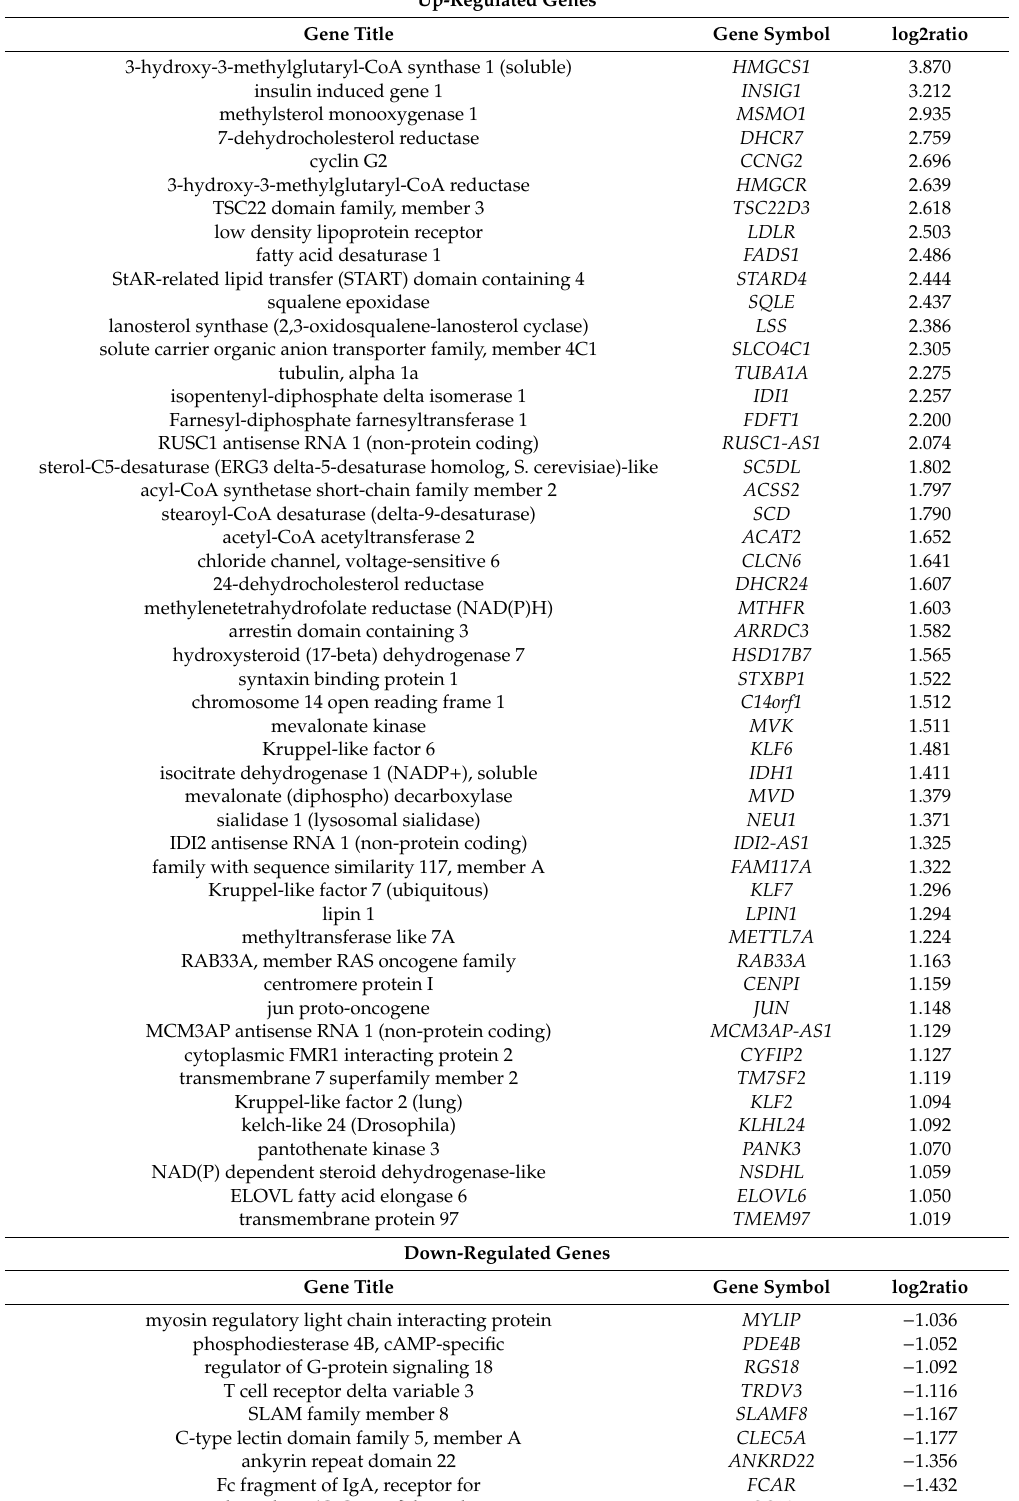
Table 1. SPS8 induced a dramatic upregulation of gene expression in 50 genes and a downregulation in nine genes (fold change ≥ 2.0, p < 0.05) using microarray platform A ff ymetrix HG-U133A plus 2